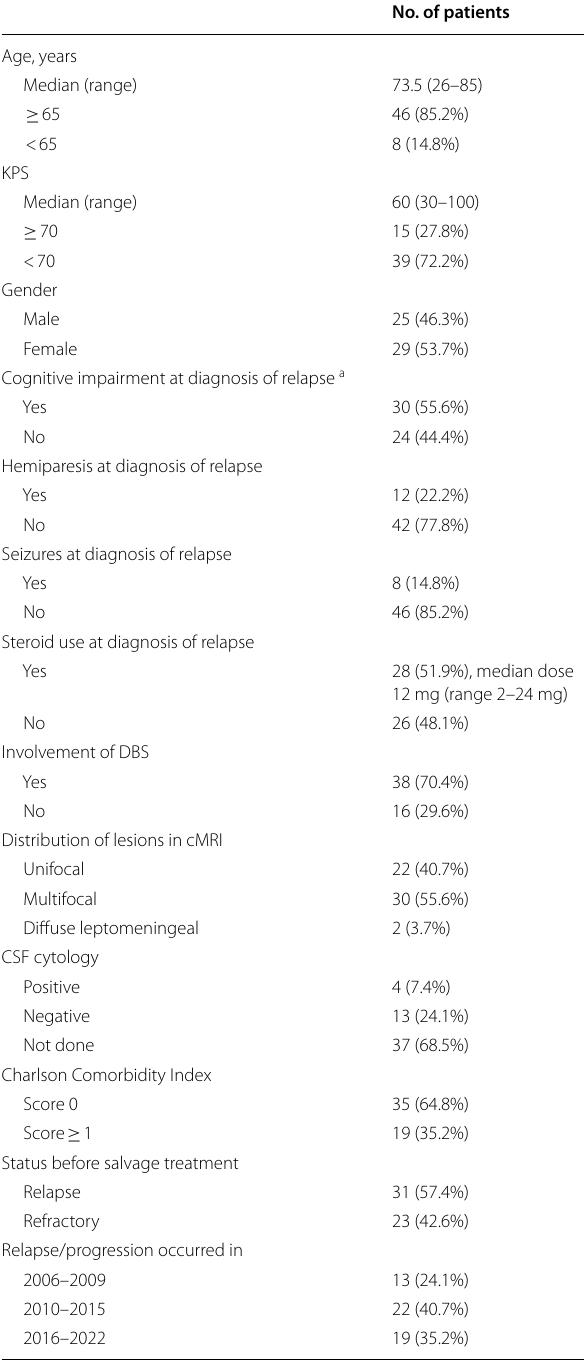
Table 1 Patient characteristics at first relapse/progression (n 54) =